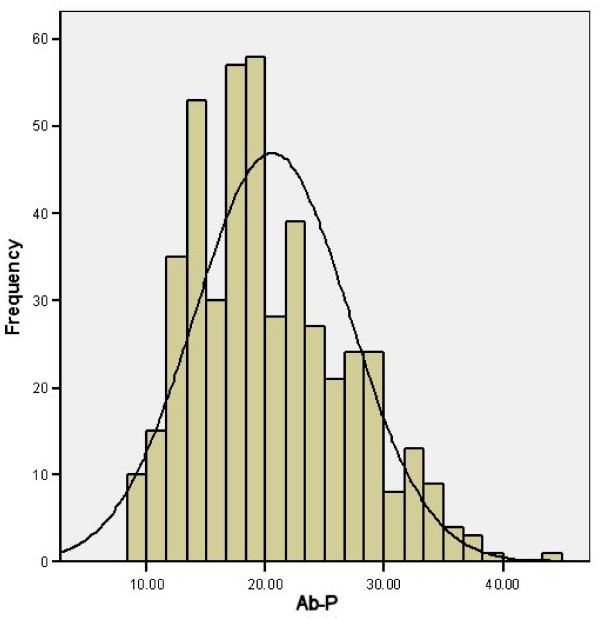
Histogram of Ab-P.